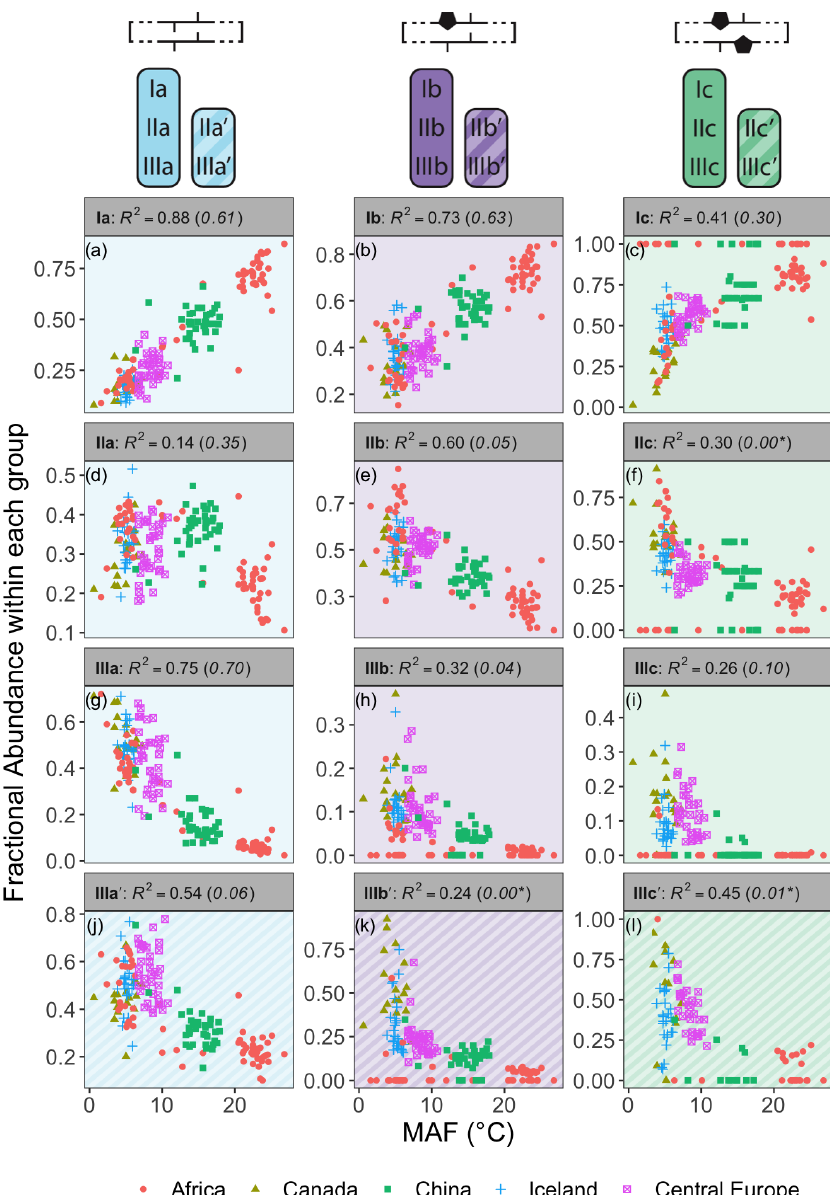
Figure 7. Relationships between the average air temperature of months above freezing (MAF) and brGDGT FAs calculated within the Meth set. R 2 values are provided for each subplot, with R 2 values for the standard Full FAs given in parentheses for comparison. P values were < 0.01 except where marked with an asterisk. Note that plots of IIa (cid:48) , IIb (cid:48) , and IIc (cid:48) are redundant because they exactly mirror those of IIIa (cid:48) , IIIb (cid:48) , and IIIc (cid:48) , respectively, and are therefore not